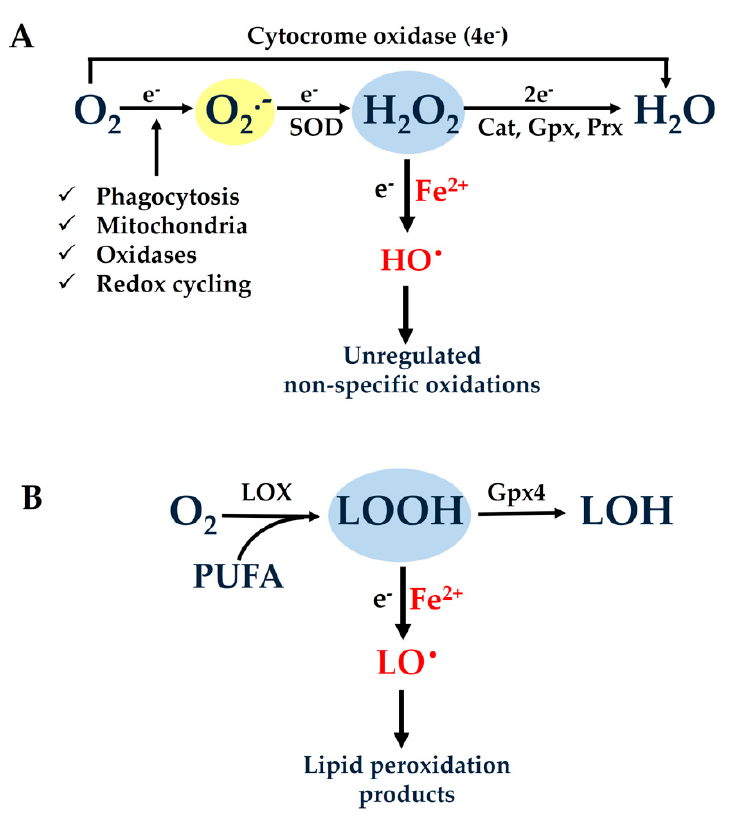
Figure 1. ( A ) Most of the oxygen (O 2 ) consumed by aerobic organisms is reduced with four electrons to H 2 O in the last step of the mitochondrial respiratory electron transport chain by the enzyme cytochrome oxidase (complex IV). However, a small portion of O 2 undergoes single electron reduction, thus producing superoxide anion (O 2 •− ), which is rapidly converted to hydrogen peroxide (H 2 O 2 ) by the action of the enzyme superoxide dismutase (SOD). The generated H 2 O 2 is further reduced, either enzymatically by two electrons to H 2 O through the action of the enzymes catalase (Cat), glutathione peroxidase (Gpx), and peroxiredoxin (Prx), or non-enzymatically by one electron, thus leading to the generation of extremely reactive hydroxyl radicals (HO • ). The latter reaction, which requires available ferrous iron (Fe 2+ ), is known as the “Fenton reaction” and generates reactive intermediates that are able to indiscriminately oxidize cell components. ( B ) Lipids and fatty acids located in membranes and lipoproteins can also incorporate O 2 and be peroxidized by the action of the enzyme “lipoxygenase” (LOX). The generated lipoperoxides (LOOHs) can be reduced to the corresponding alcohols by the specific membranous enzyme “glutathione peroxidase 4” (Gpx4). Like H 2 O 2 , LOOHs can interact with available ferrous iron (labile iron), leading to the generation of highly reactive lipid alcoxyl radicals (LO • s), which can further promote the peroxidation of membrane lipids. However, a small amount of consumed O 2 , even under physiological conditions, undergoes single electron reduction to produce superoxide anions (O 2 •− ), which are